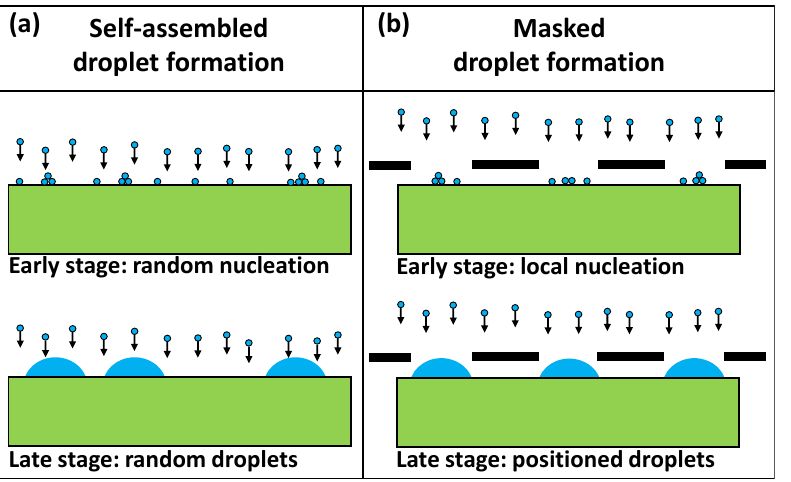
Figure 1. ( a ) Schematic of self-assembled droplet formation with planar deposition of the droplet material on a substrate, random nucleation, and formation of metal droplets without lateral order. ( b ) Schematic of an area-selective deposition process where Ga droplets are site controlled on an Al 0.3 Ga 0.7 As surface by apertures in a mask which consists of a 100 nm thick Si 3 N 4 -membrane on a Si(100) support